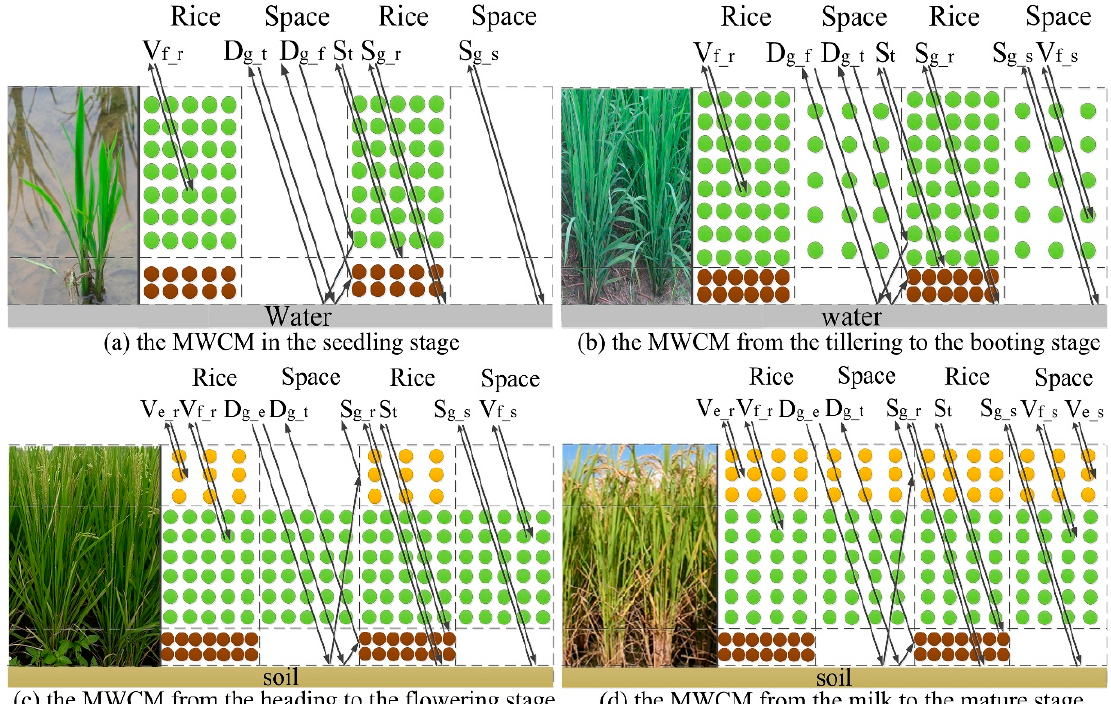
Figure 5. ( a – d ) The adaptive MWCM according to the rice phenological stage. The yellow, green, and red dots consist of ear, leaf, and stem layers, respectively. The scattering mechanisms of the rice canopy are shown.